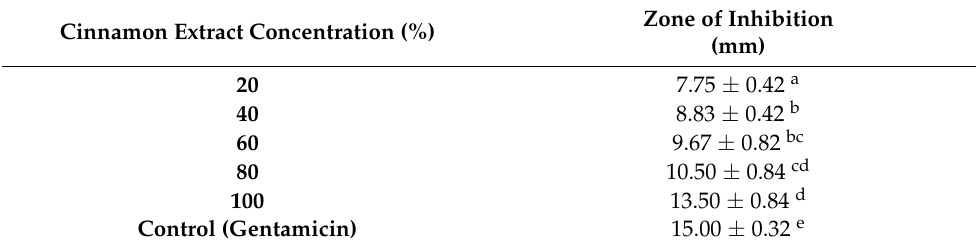
Table 1. Antibacterial activity of cinnamon extract for Pseudomonas aeruginosa ATCC 27853. Cinnamon Extract Concentration